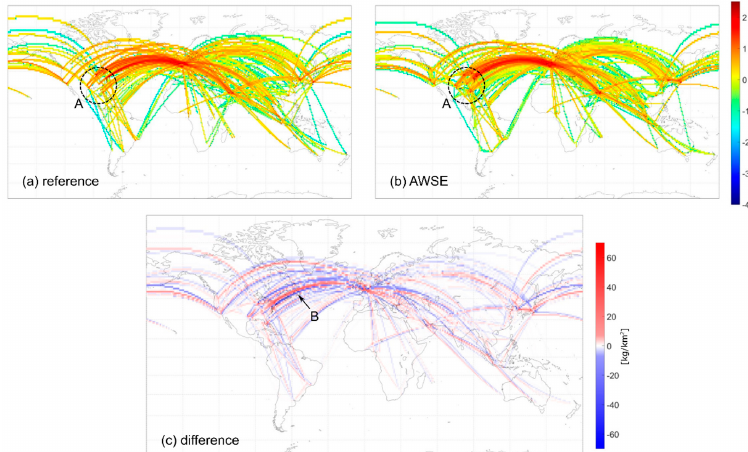
Figure 8. Inventories for fuel consumption for the ALL study and the FXD setting combined for leader and follower. Reference scenario ( a ), AWSE scenario ( b ); Inventory for difference in fuel consumption for the ALL study and the FXD setting, combined for leader and follower ( c ). Note: the rasterization effect is due to the cell size of the inventories.